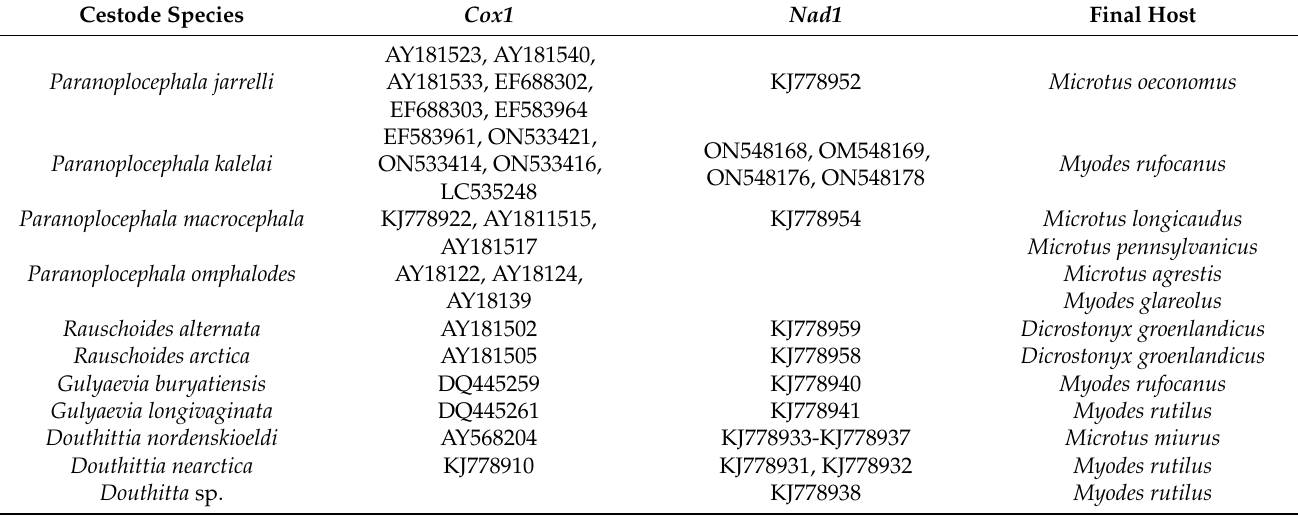
Table 2. The sequences list the anoplocephalid cestodes involved in the phylogenetic analysis. The list is given according to